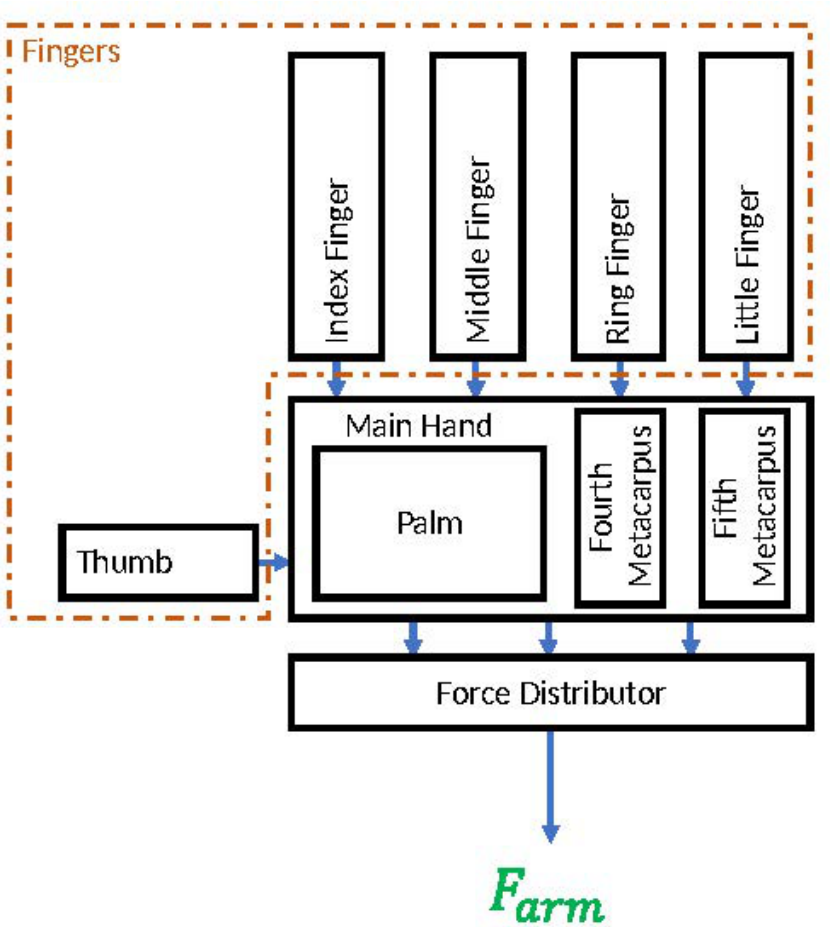
Figure 1. Overallblock diagram of Karla. The design consists of three parts: a force distributor, the main hand, and fingers. To make a grasping motion, the user pulls the main string with force F arm